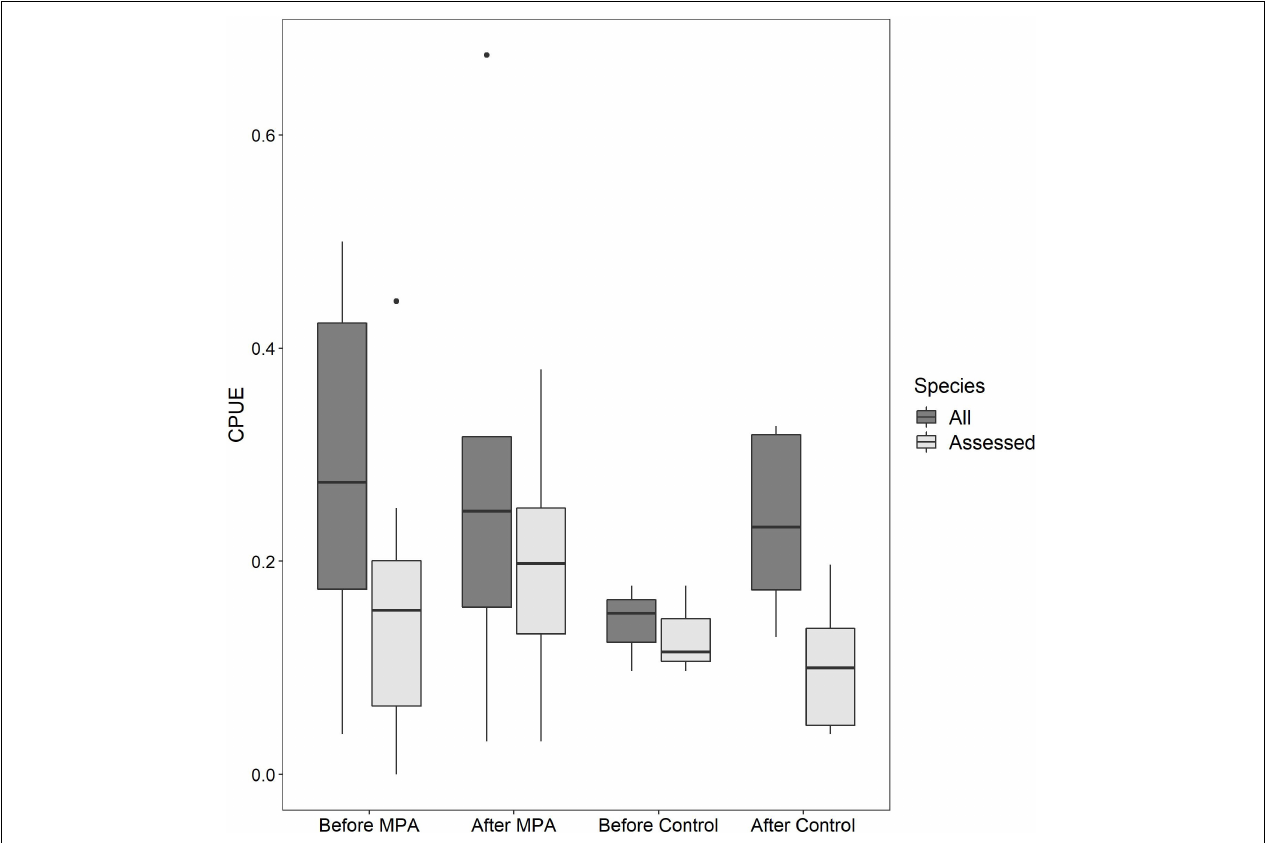
FIGURE 3 | Boxplots of per-trip catch per unit effort among the four crosses of Area and Period using all reef fish catch-per-unit-effort (CPUE) (dark boxes) and CPUE for only assessed species (light